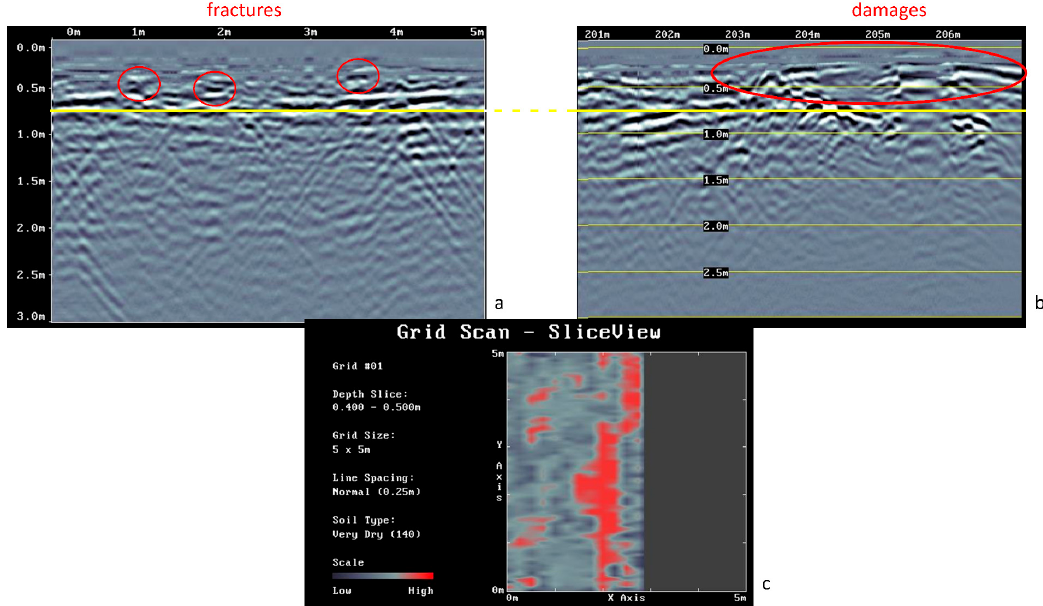
Figure 11. ( a ) Illustrates the internal damage to the “winged” structure of the bridge; ( b ) Shows superficial damage linked to the failure of the travertine surface of the sidewalks; ( c ) highlights the depth-slices showing evident anomalies due to detachments and cracks (in red).